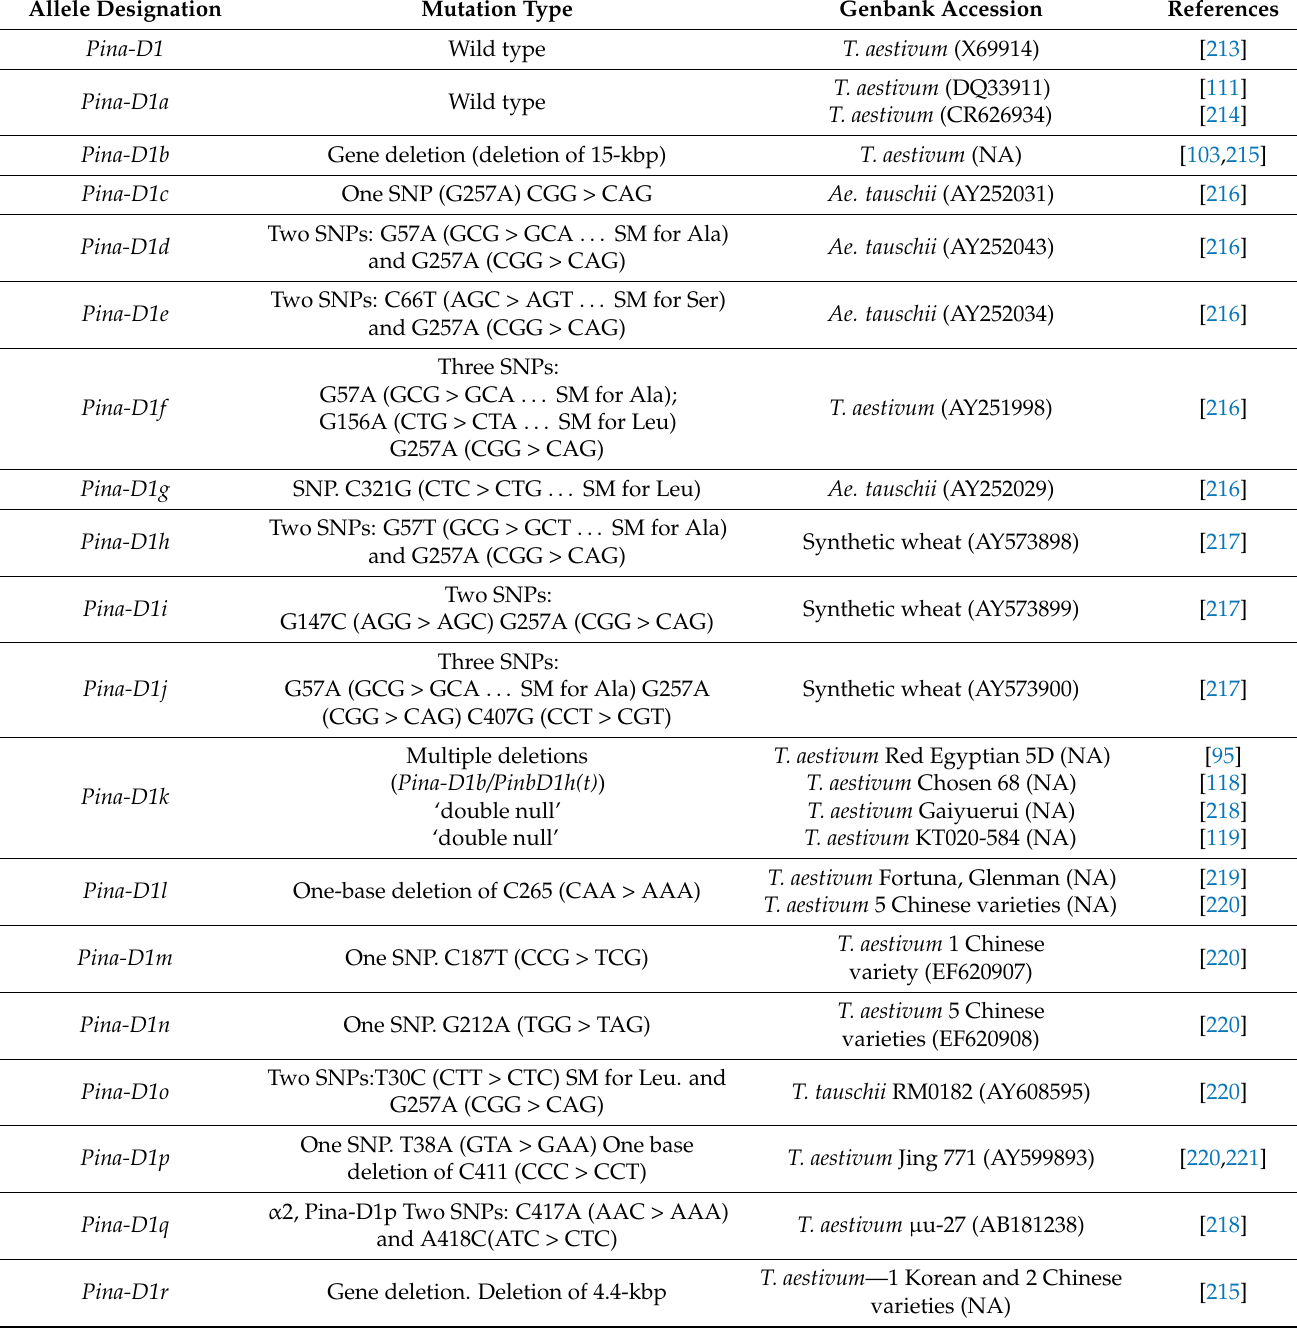
Table A1. Allelic variants of the Pina-D1